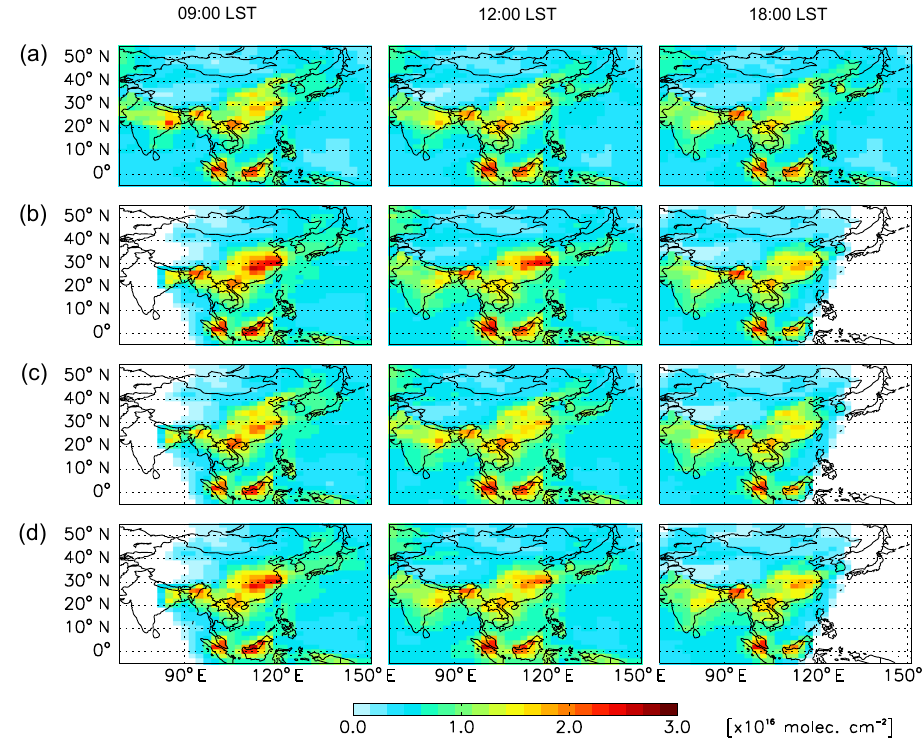
Figure 3. (a) HCHO VCDs simulated by GEOS-Chem at 09:00, 12:00, and 18:00local standard time (LST) of Seoul on 21 June 2009. (b) Retrieved HCHO VCDs with AMF m . (c) Retrieved HCHO VCDs with AMF h . (d) Retrieved HCHO VCDs with AMF mh